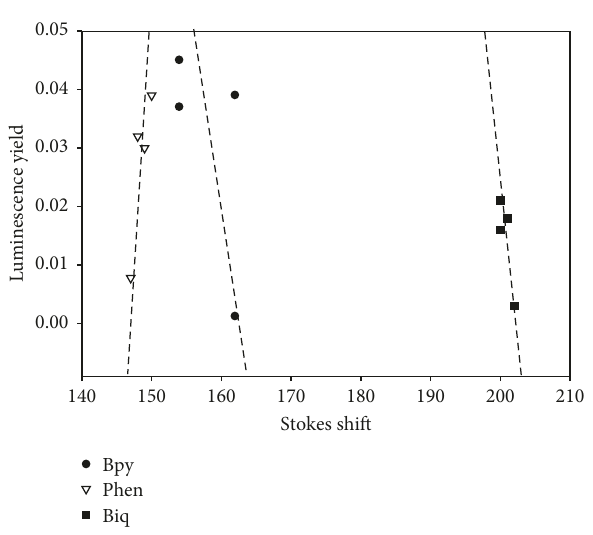
Figure 4: Luminescence yield versus peak Stokes shift for Ru(II) complexes (dotted lines are a linear guide for the